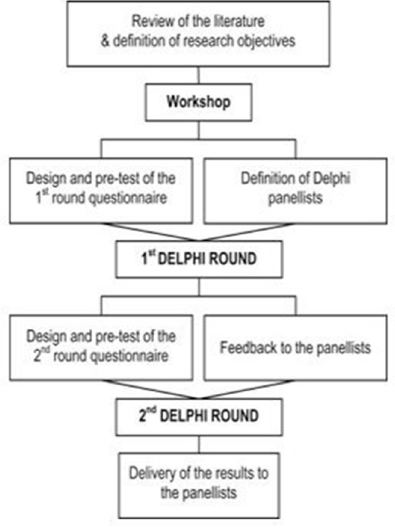
Figure 1. Delphi process (source model).